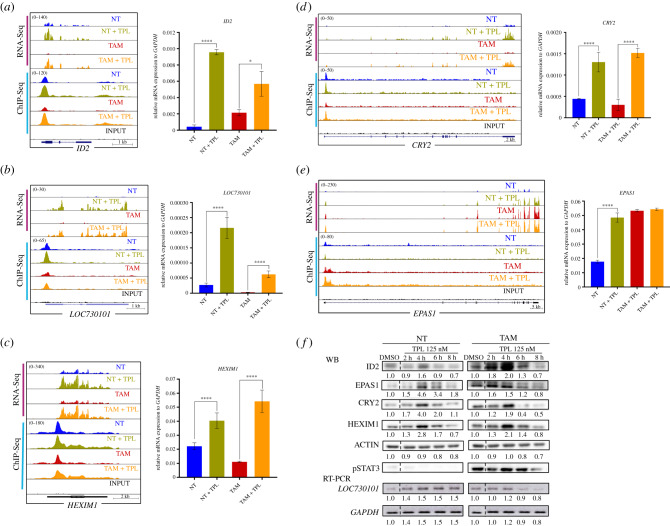
Analysis of overexpressed genes and its protein products in response to TPL treatment. (a) ID2 gene, representation of the Genome Browser, RNA-Seq (pink bar) and ChIP-Seq (blue bar), comparing the NT (blue), NT + TPL (green), TAM (red), TAM + TPL (orange) and the INPUT (black). qRT-PCR corroboration is also shown. (b) lncRNA LOC730101 representation in the Genome Browser. qRT-PCR experiments are also show confirming the increase of this transcript after TPL treatment. (c) HEXIM Genome Browser image. qRT-PCR experiments confirming HEXIM1 overexpression by TPL. (d) CRY2 gene increase with the TPL treatment shown in the Genome Browser image, confirmation by qRT-PCR is also shown. (e) EPAS1 Genome Browser image and qRT-PCR corroboration. (f) Example of a time-course experiment of the overexpression of the ID2, HEXIM1, CRY2 and EPAS1 proteins in response to TPL by Western blot analysis. STAT3 phosphorylated is an indicator of the transformed phenotype in TAM cells. A time-course analysis of the overexpression of the LOC730101 lncRNA by RT-PCR is also shown. The dashed line indicates where the images were cut in order to avoid another treatment time (30 min) included in the experiment. Densitometric analyses were performed using actin or GAPDH as a loading control in Western blot and RT-PCR, respectively; the relative quantification is indicated under each blot and the data showed as a representative example from three biological replicates. Data from (a) to (e) represent three biological replicates. Graphs show mean values ± s.d. (standard deviation). Significant differences were analysed by t-test. Statistical significance is indicated (*p < 0.05 or ****p < 0.0001).